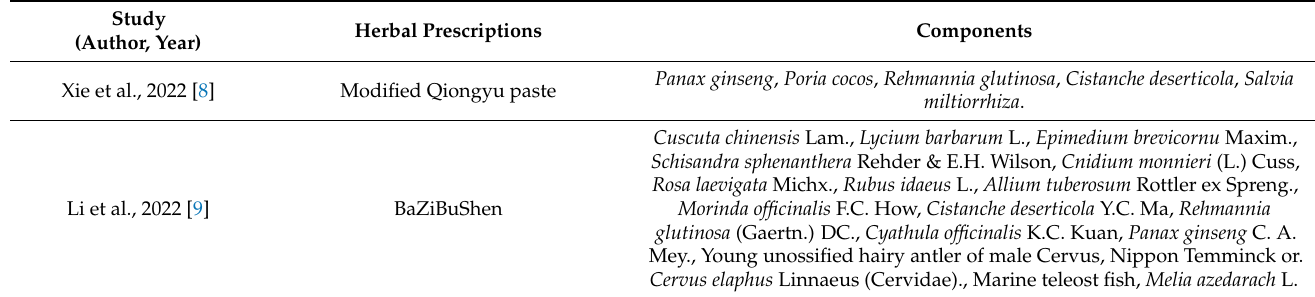
Table 2. Composition of multi-compound herbal